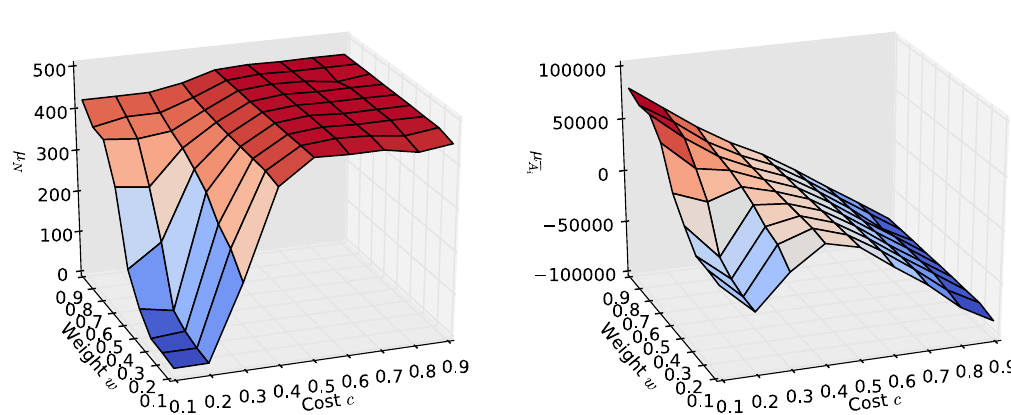
Figure 8. Varying cost c and weight w with a population of 10 agents after 5000 rounds. The CPR game parameters are listed in Fig. 1. ( a ) The influence of cost and weight on the resource level N ; low costs induce greed, whereas low weights can be surprisingly sustainable. ( b ) The influence of cost and weight on the asset level A ; profits decrease with cost, but over-harvesting also diminishes profits due to resource